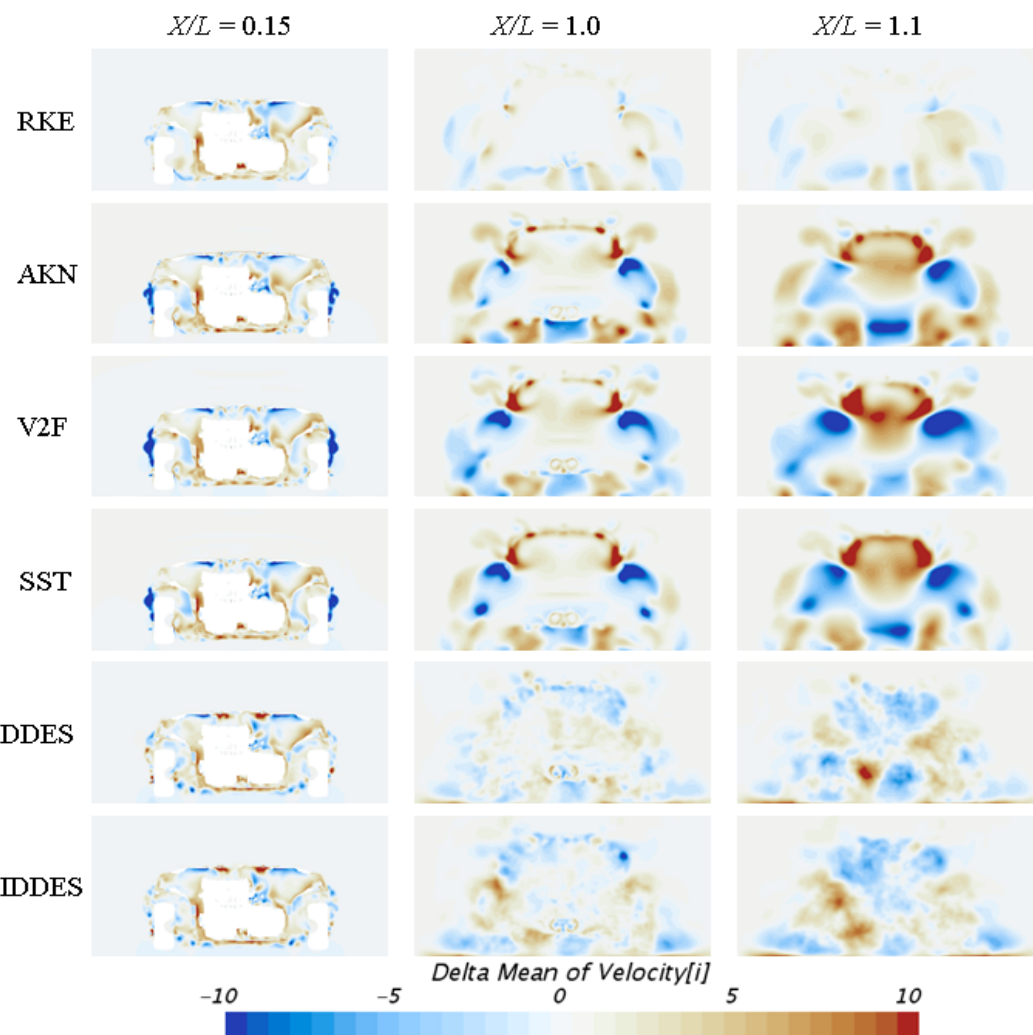
Figure 21. Delta streamwise velocity (velocity field in Case 2 relative to that of Case 1) on selected plane sections from all